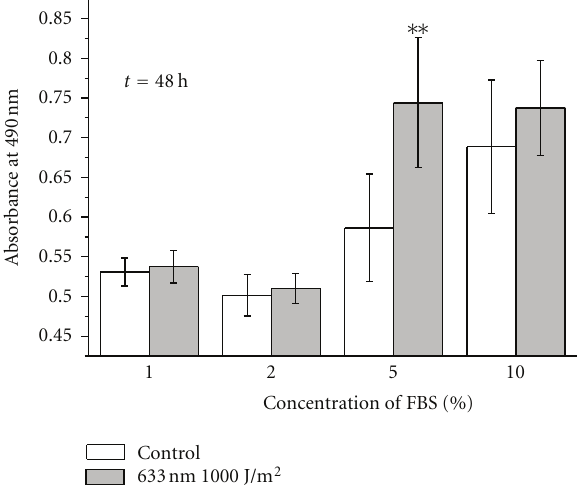
Figure 4: The proliferation of HeLa cells in di ff erent FBS concen- trations (laser wavelength λ = 658 nm, energy density 1000 J/m 2 , irradiation time 100s). The absorbance value was assessed at 48 h after laser irradiation. Error bars were from three independent experiments, ∗ P < 0 . 05.